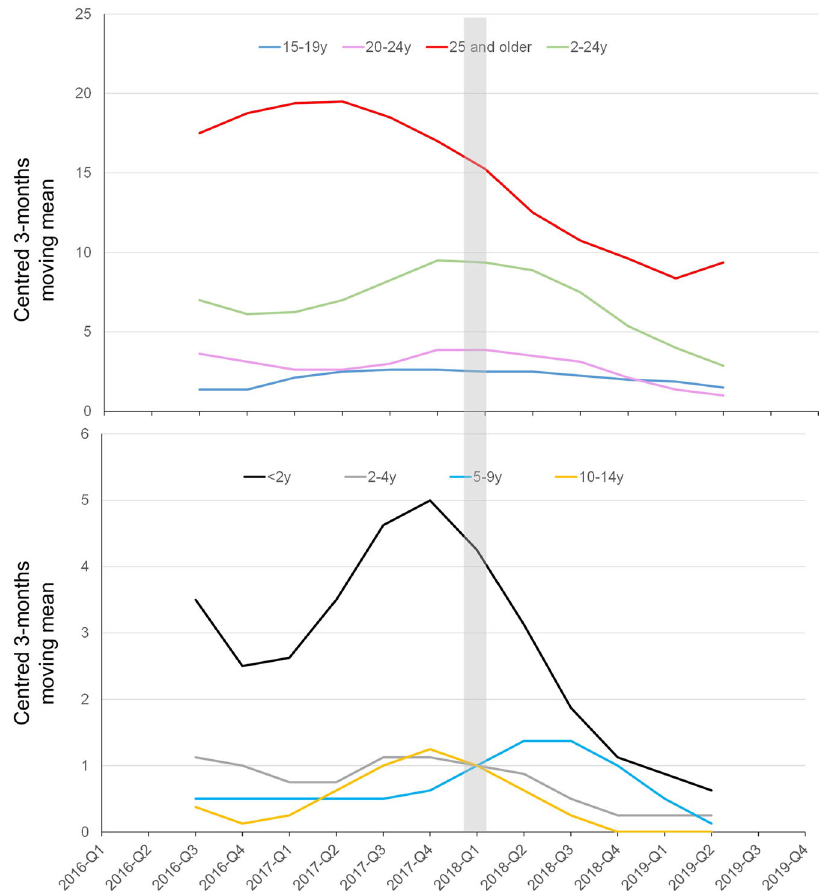
Fig. 3 Evolution of a number of cases of IMD due to serogroup C per age group during the period 2016 – 2019. Time-series analysis was used with the data expressed per quarter of each studied year. The data were expressed by the centred 3-months moving mean per age group. Age groups are indicated in different colours with the corresponding number of cases per year. The date of the implementation of mandatory vaccination is indicated by a grey